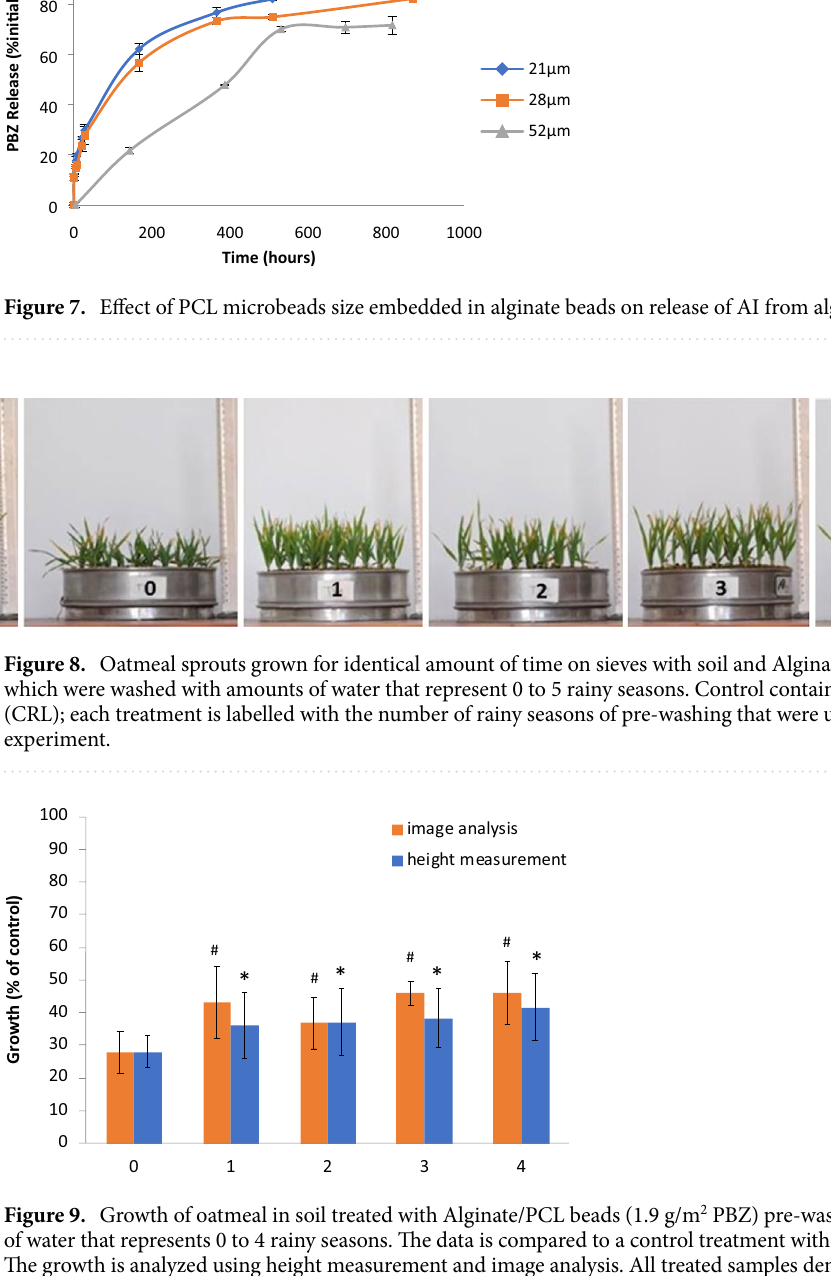
Figs. 3 and 4). Analysis of RGB variation values was performed for both seasons for all plots and normalized to untreated terrain which constitutes the negative control in the experiment (Fig. 10). Analysis result for two seasons resulted in different trends for each treatment. For the neat 2 g of PBZ/m 2 treatment (PBZ*2), the lowest biomass for the first season (22% on average) was recorded. The second season was about two times higher than the first season for this treatment (42% in average). For the granular treatment containing 2 g of PBZ/m 2 (T), the highest biomass for both first and second season were recorded (72% and 50%, respectively). A decline of 30% in the second season relative to the first season was evident in this treatment. Finally, for the combined granule and neat PBZ treatment, TPBZ (i.e., 2 g PBZ/m 2 in granules and 1 g neat PBZ/ m 2 ) both seasons showed relatively similar vegetative growth (29–32% on average).